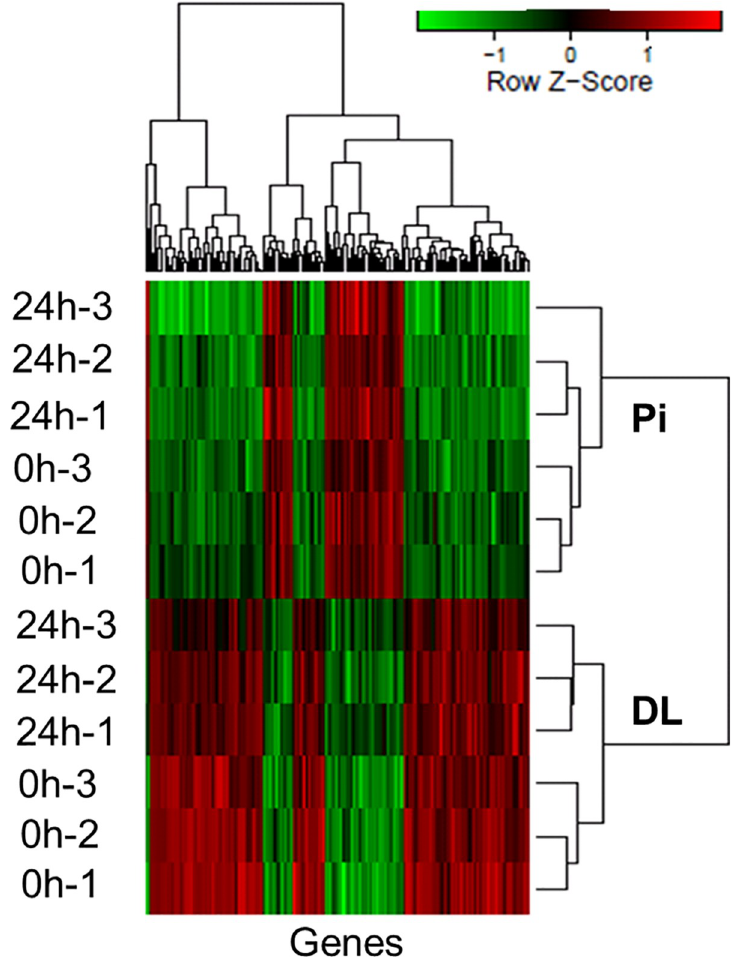
Fig 3. Hierarchical heat map showing differential gene expression over the contrast pairs. The figure includes DEGs between vaccinated PBMCs of DL pigs compared to that of Pi pigs. The normalized log2 transformed values determined by Affymetrix GeneChip porcine gene 1.0 ST array in PBMCs collected at 0 and 24 h post PRRSV vaccination both in DL and Pi pigs. The cutoff values of log2 fold change as either > 1.5 or < -1.5 and FDR < 0.05 were considered for statistical significance. Each column represents one array from each of replicate